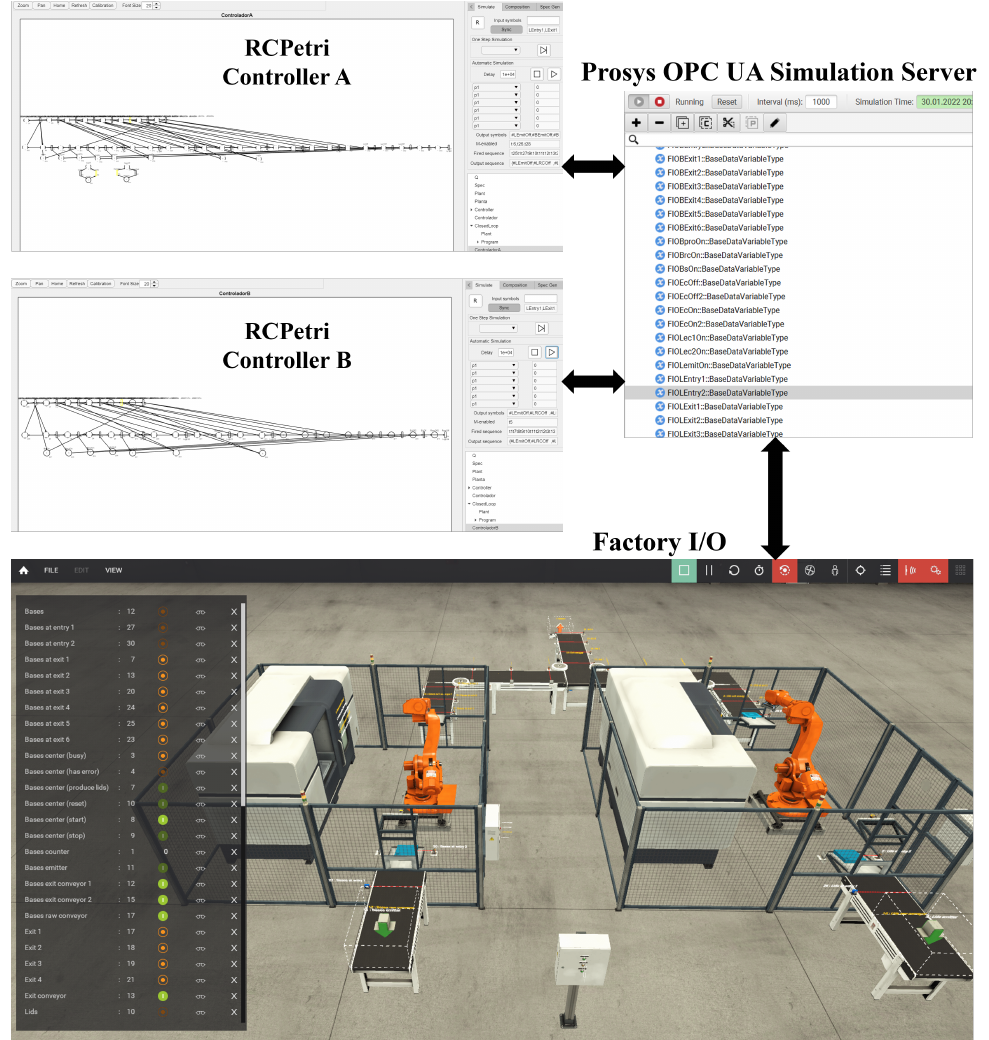
Figure 13. Simulation and control of the robotic manufacturing system. Controller A drives the lids production (left cell), while Controller B drives the bases production (right cell). Each control program is running in a different